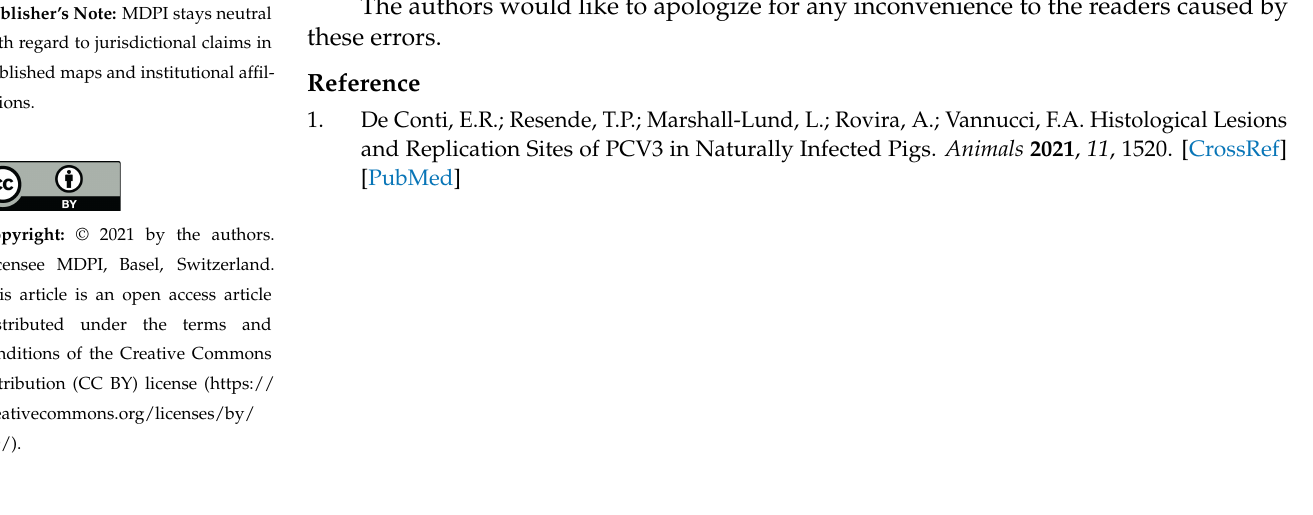
Figure 4 (a) “Lymph node” needs to be replaced by “Spleen”. (b) “Lymph node” needs to be replaced by “Spleen”. Figure 5 (a) “Liver” needs to be replaced by “Pancreas”. (b) “Liver” needs to be replaced by